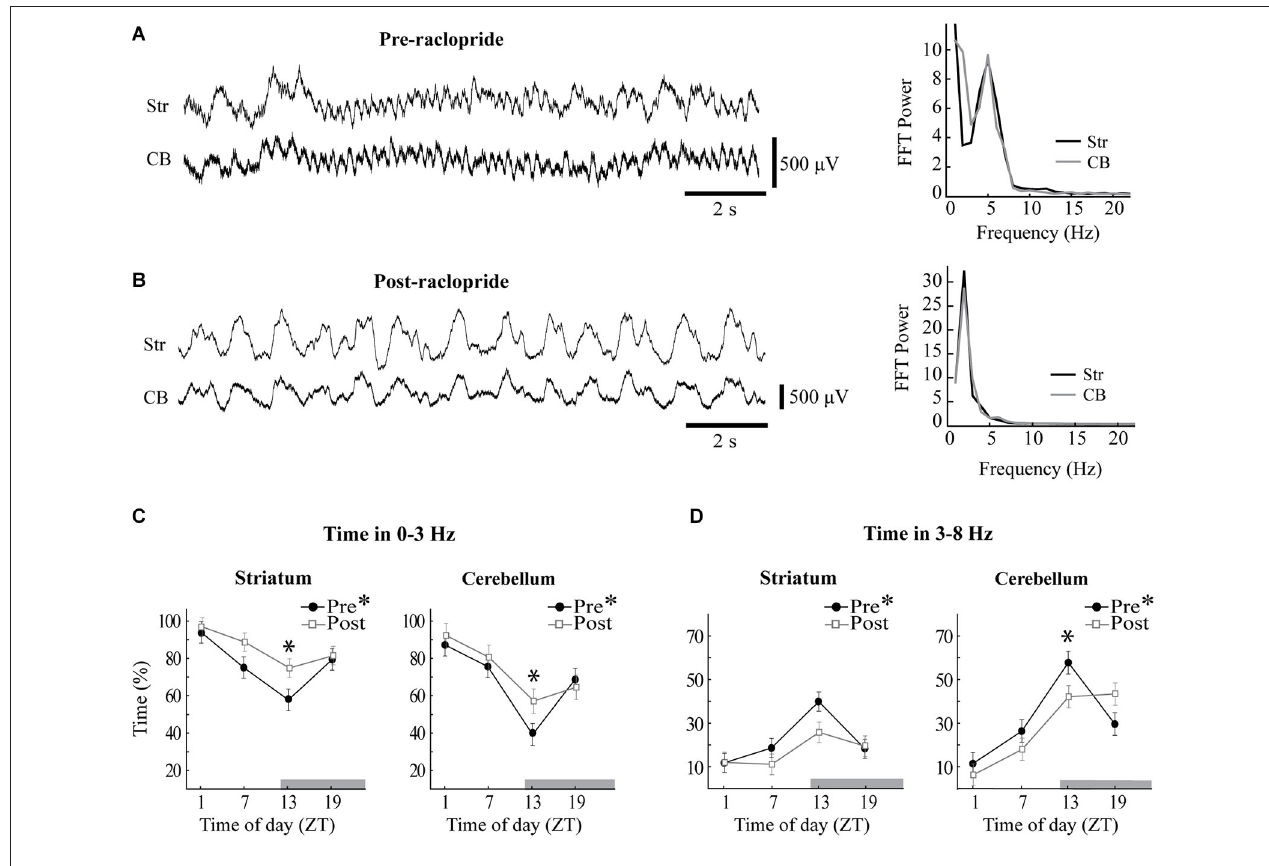
content in striatal and cerebellar recordings. (C,D) The percentage of time that each recording site spent within 0–3 Hz (C) or 3–8 Hz (D) oscillations was calculated before (filled circles) and after (open squares) raclopride administration. Asterisks in the figure legend indicates a main effect of ZT at baseline (pre-raclopride), asterisks above the data points indicate significant effects of raclopride in the Tukey post hoc analysis, p <